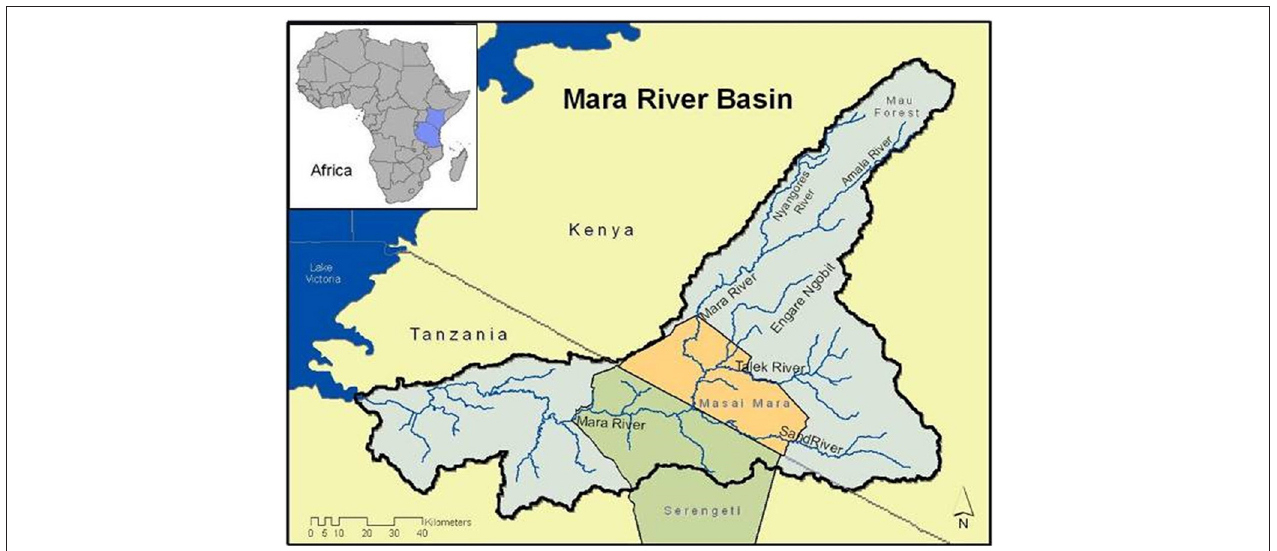
FIGURE 1 | Map of the Mara River Basin (Reza,